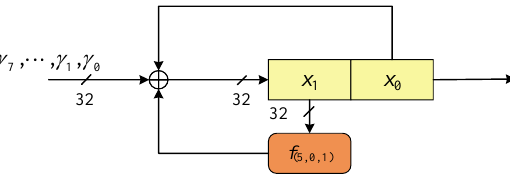
Figure 2. Simeck Box (SB-64).